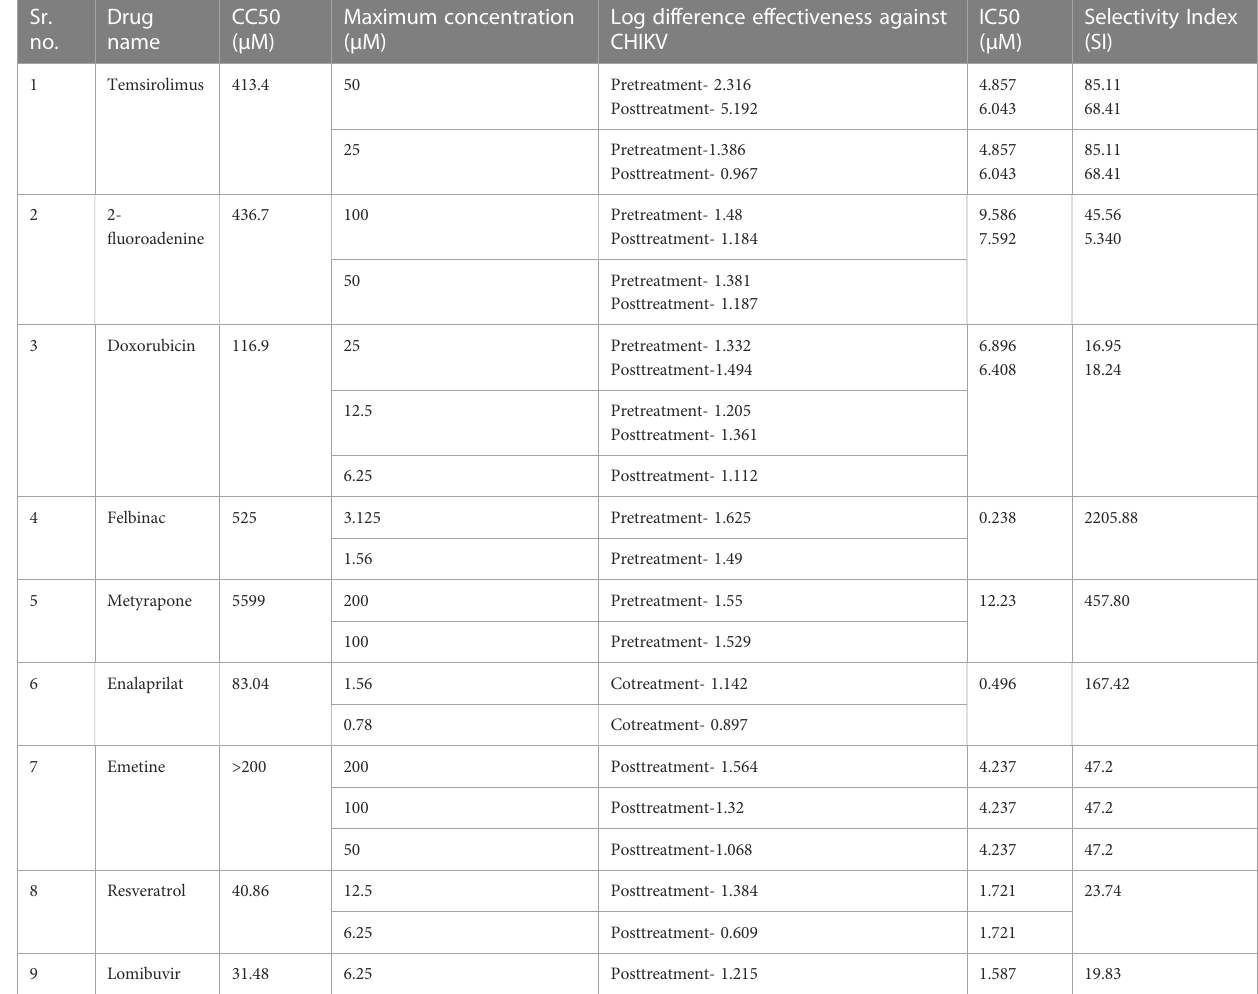
TABLE 3 Summary of effective inhibition under different treatment conditions. Sr.